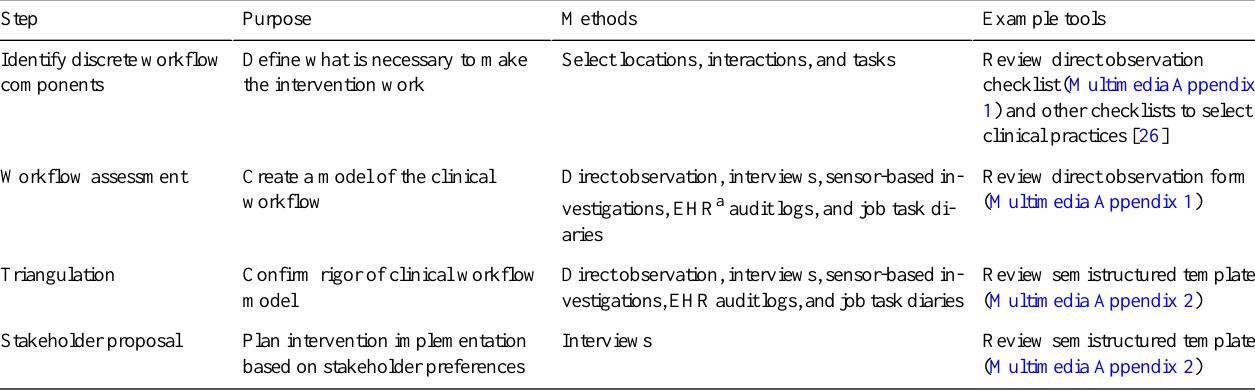
Table 1. Steps for conducting a workflow